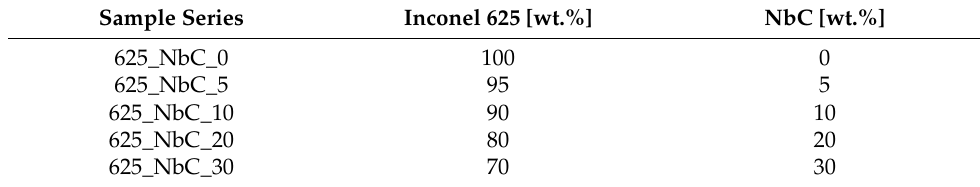
Table 2. Pure Inconel 625 polycrystals were also prepared by SPS as reference samples for experimental work. Table 1. Composition of provided Inconel 625 powder, where bal. stands for balance composition. Element Table 2. Composition of samples.